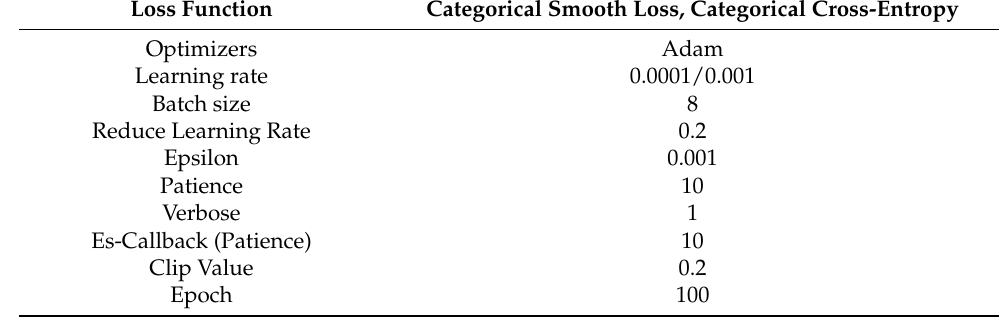
Table 3. Experiment hyperparameters optimization and